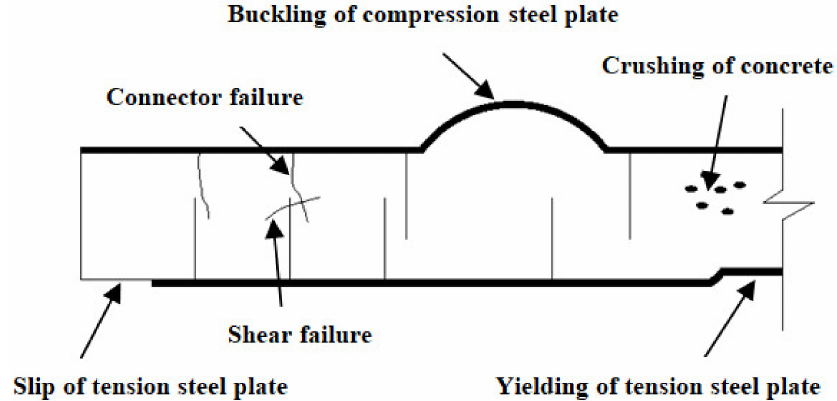
Figure 2. Typical failure modes of SCS beam